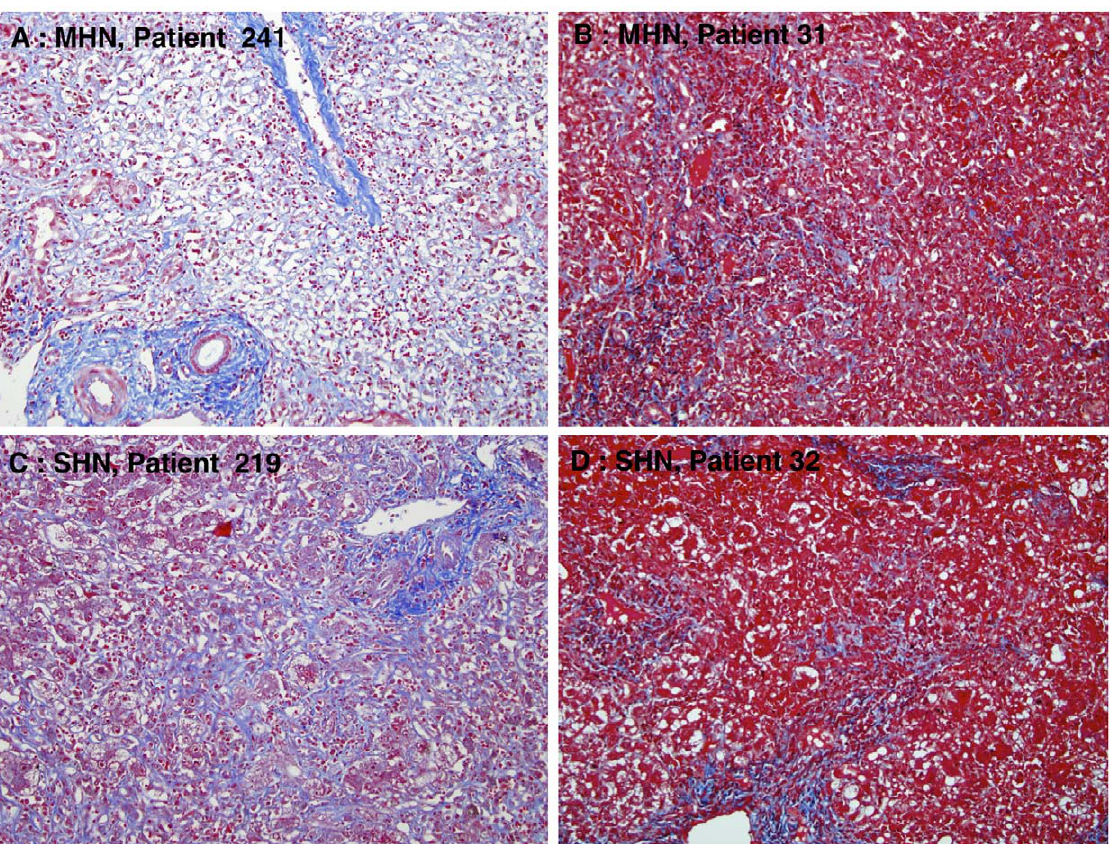
Figure 2. Liver fibrosis in HBV-associated ALF. Delicate fibrosis is evident in the zones of collapsed necrotic parenchyma. The mature collagen of portal areas stains dark blue, while the newer collagen stains light blue (Masson’s trichrome,